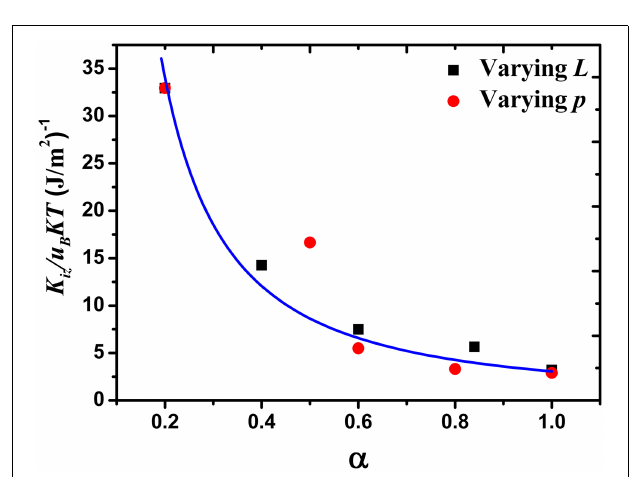
FIGURE 10 | Variation of φ P as a function of α with varying length and